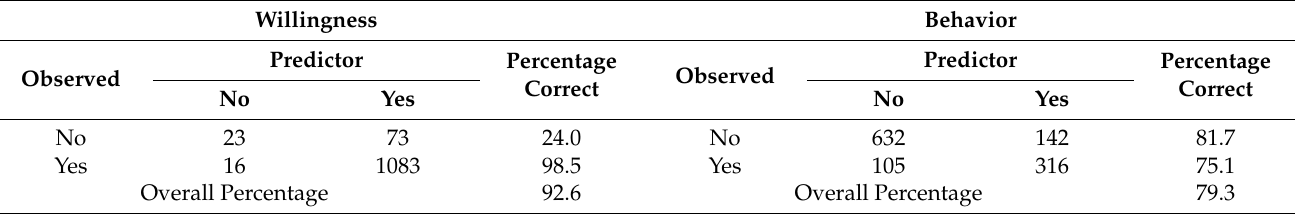
Table 5. Predictive ability of the regression